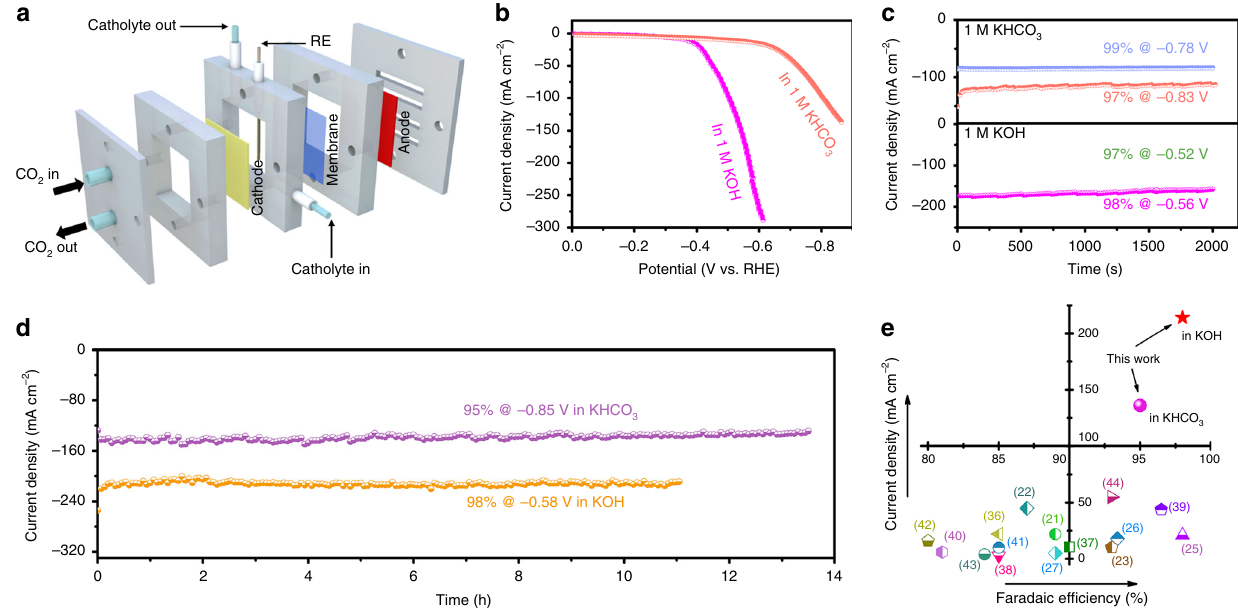
Fig. 3 Electrochemical carbon dioxide reduction measurements in the fl ow cell. a Schematic illustration of the fl ow cell con fi guration. b Polarization curves of nanotube-derived Bi (NTD-Bi) in 1 M KHCO 3 or 1 M KOH. c Chronoamperometric responses at a few different potentials in the two electrolytes. d Long- term amperometric stability in the two electrolytes. e Comparison of our results with previous data in terms of current density and Faradaic ef fi ciency; corresponding reference numbers are included in